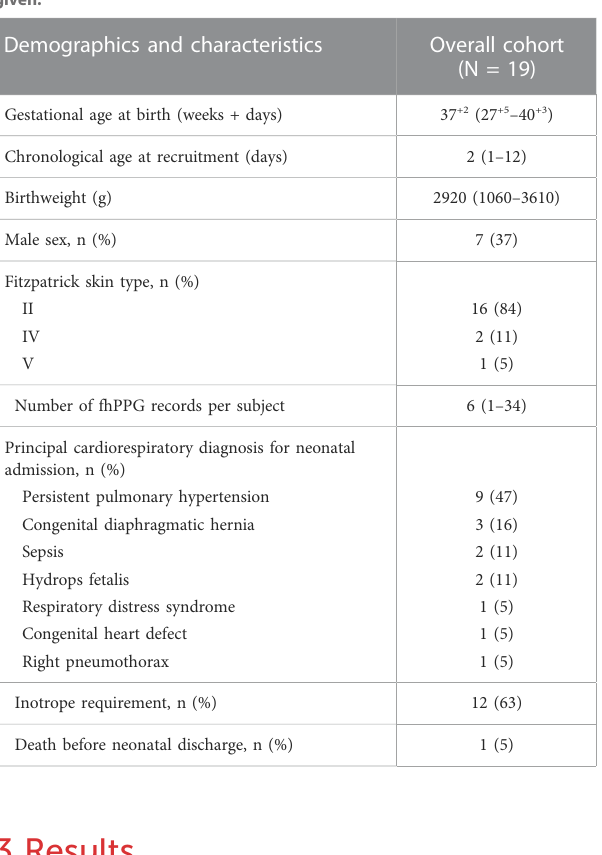
TABLE 1 Demographics of the study. All values are either absolute values or median and interquartile ranges (IQR). Primary reason for admission to NICU given.